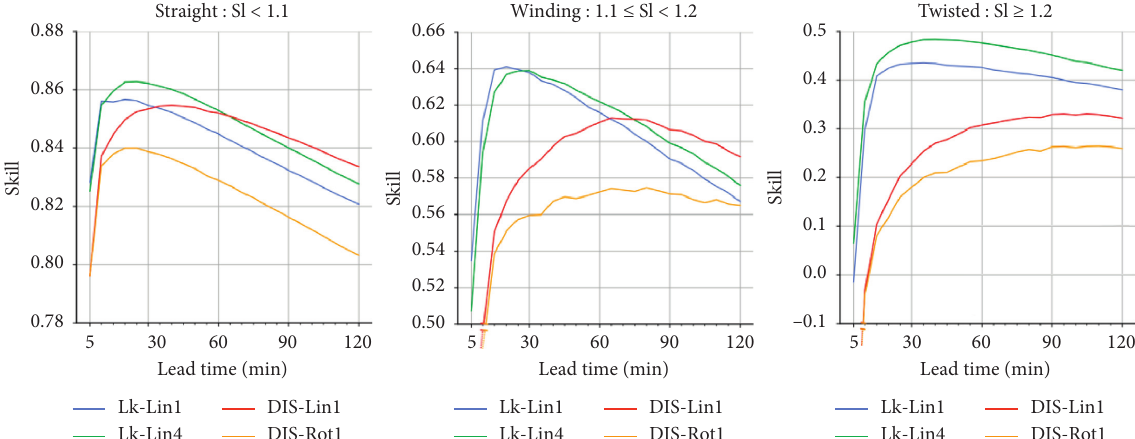
Figure 9: The mean model skill over each lead time with regard to location prediction for different extrapolation models and sinuosity conditions. Please note that the very low skill values of the DIS-based models at 5-minute lead time (in the winding and twisted groups) are hidden by the scaling of the y -axis. At five-minute lead time, both models only have a skill of about 0.35 (winding) and − 0.55